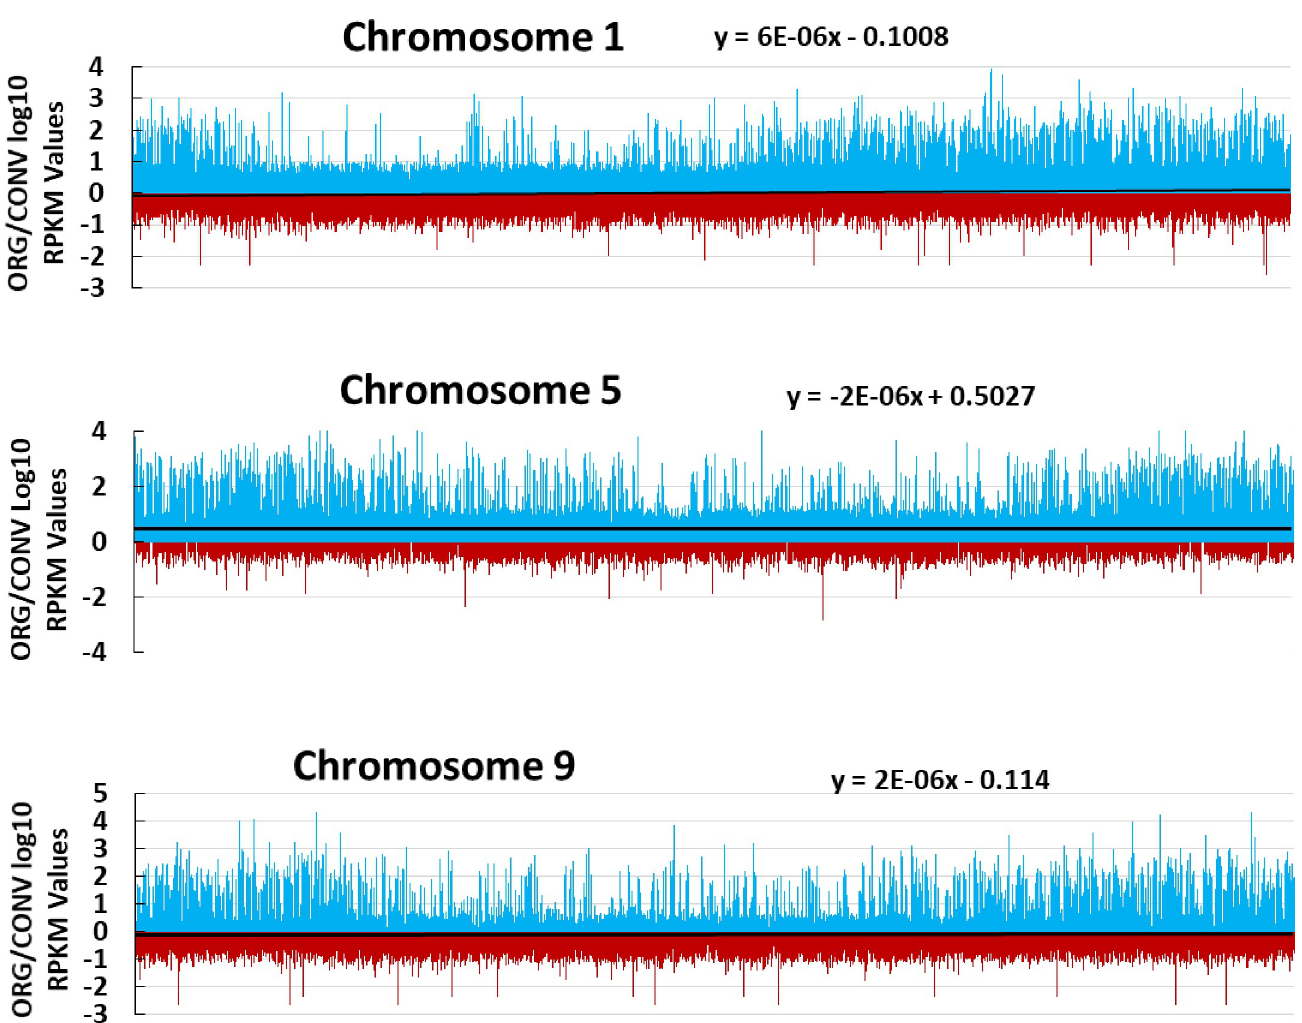
Fig 1. Representative ORG and CONV log10 RPKM ratio Manhattan plot representations of expression values across S . lycopersicum chromosomes. Every bar is indicative of the log10 expression ratio of Fruit and Leaf ORG RPKM values over Fruit and Leaf CONV RPKM values. Trendlines with slope equations indicate propensity of treatment activated loci across the chromosome. Chromosome graph lengths are not indicative of chromosome length. Red bars indicate a higher log10 ratio in the CONV treatment and blue bars indicate higher expression in the ORG treatment at any given position on the chromosome. Trend lines were graphed to indicate a predominance of chromosomal activity either in the ORG treatment (positive y-intercept value) or in the CONV treatment (negative y- intercept value). All 12 mapped chromosomes can be found in S3 Fig. 12 read files, representing three cDNA libraries across each of the two tissue and two treatment types were used for mapping